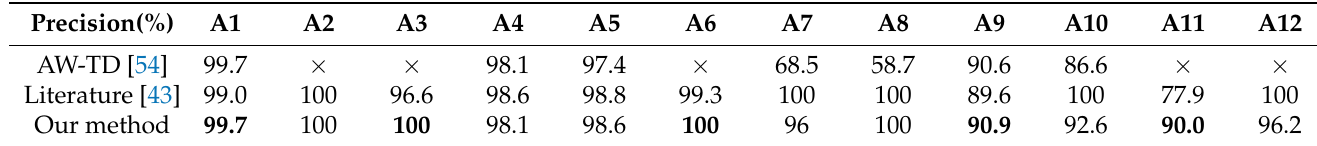
Table 5. Comparison of precision rate between the proposed method and other methods.